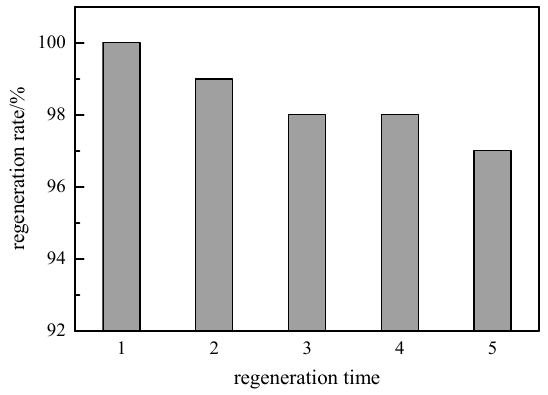
Figure 8. Regeneration effect of hybrid microspheres after adsorption.